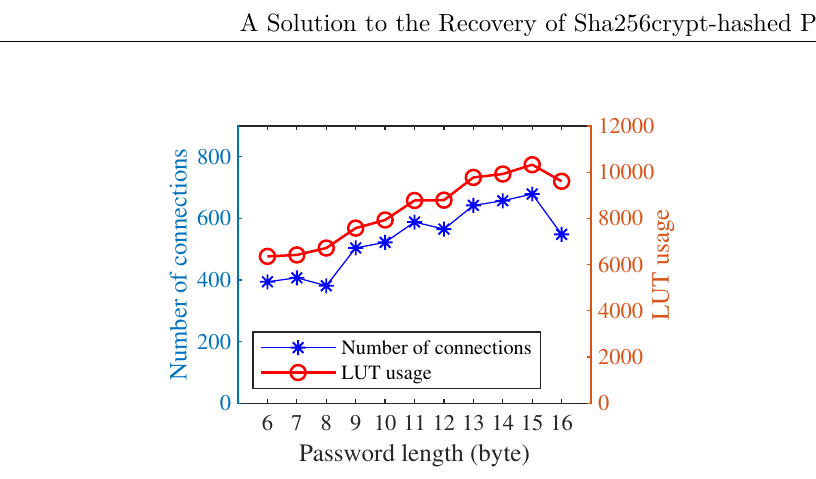
Figure 16: Number of connections in the data path and LUT usage for the data dispatch unit.